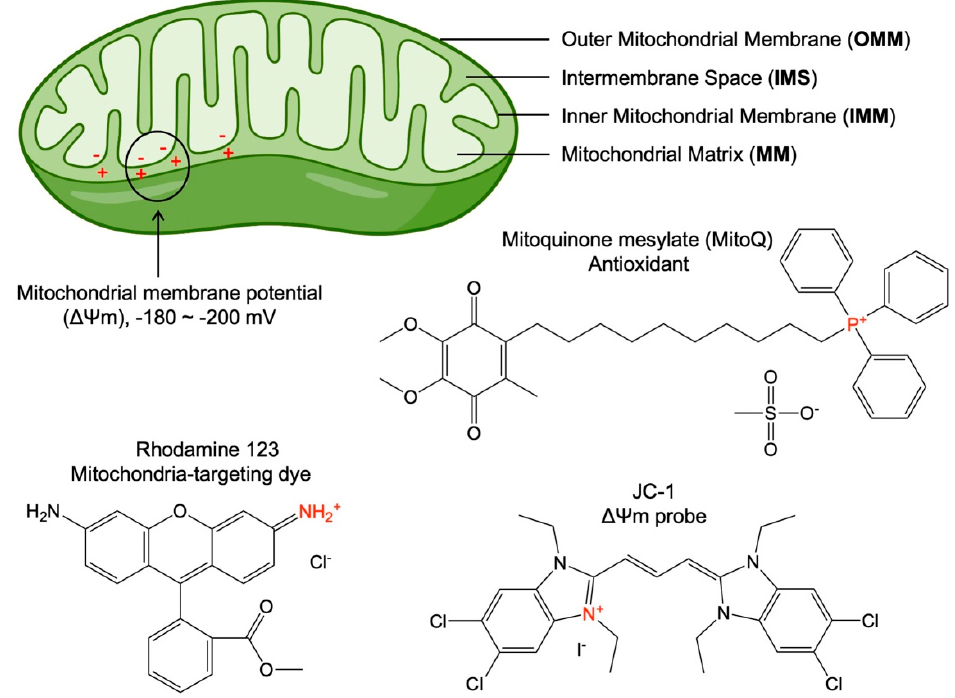
Figure 1. Schematic showing mitochondrial structure and three representative mitochondria-targeting molecules. The high mitochondrial membrane potential ( ∆Ψ m) refers to the potential difference between the negative charges in the mitochondrial matrix (MM) and the positive charges in the intermembrane space (IMS), due to the proton pumps in the inner mitochondrial membrane (IMM) that pump protons from the MM into IMS. Also shown are three delocalized lipophilic cations, such as triphenylphosphonium (TPP)-based antioxidant mitoquinone mesylate (MitoQ) (a commercial mitochondria-targeting antioxidant), Rhodamine 123 (a mitochondria-specific fluorescent dye), and JC-1 (a mitochondrial membrane potential ( ∆Ψ m) probe) that are the most well-established molecules that target mitochondria.